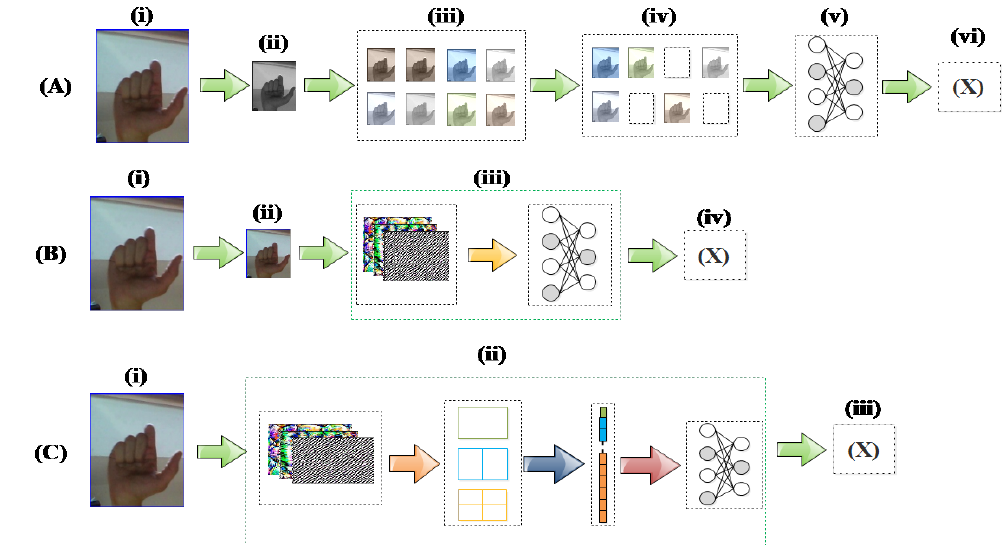
Figure 5. Step-by-step comparison of classification methods. ( A ) Traditional methods rely on image resizing and RGB to gray-scale conversion prior to classification. ( B ) in most DCNN-based methods, the input image needs to be resized. However, ( C ) the SPP layer-based DCNN has no need for image resizing.